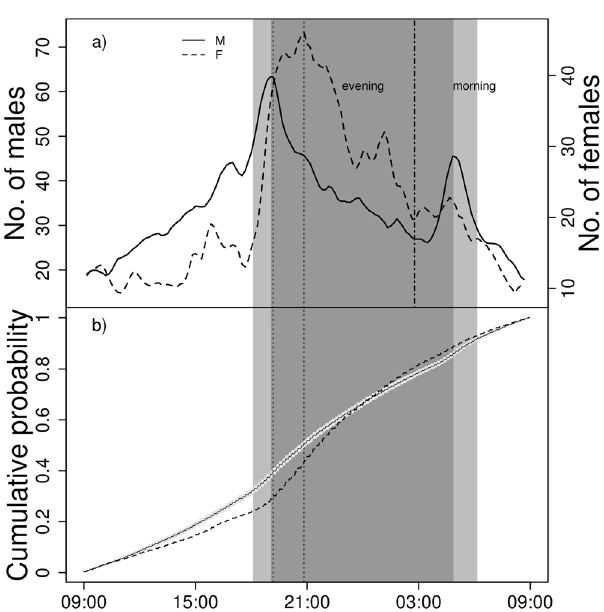
Figure 3. The male and female presence on the spawning ground in 24-hour cycles starting at the lowest observed attendance ( a ), and the rank envelope test comparing general fish presence with female presence at the spawning ground ( b ). In the upper panel, the weighted male and female curves were standardized to the same height for better comparison. Moving average with 30-minute interval was used for the plot. Male and female peaks of presence are indicated by dotted lines. Division between morning and evening period defined as points with the lowest abundance is indicated by dot-dashed line and by starting time of the plot. In the lower panel, any departure of the data from the global envelope proves the rejection of the null hypothesis that the female curve is the same as male curve. The light grey area demonstrates the shift between sunset and sunrise during the monitoring